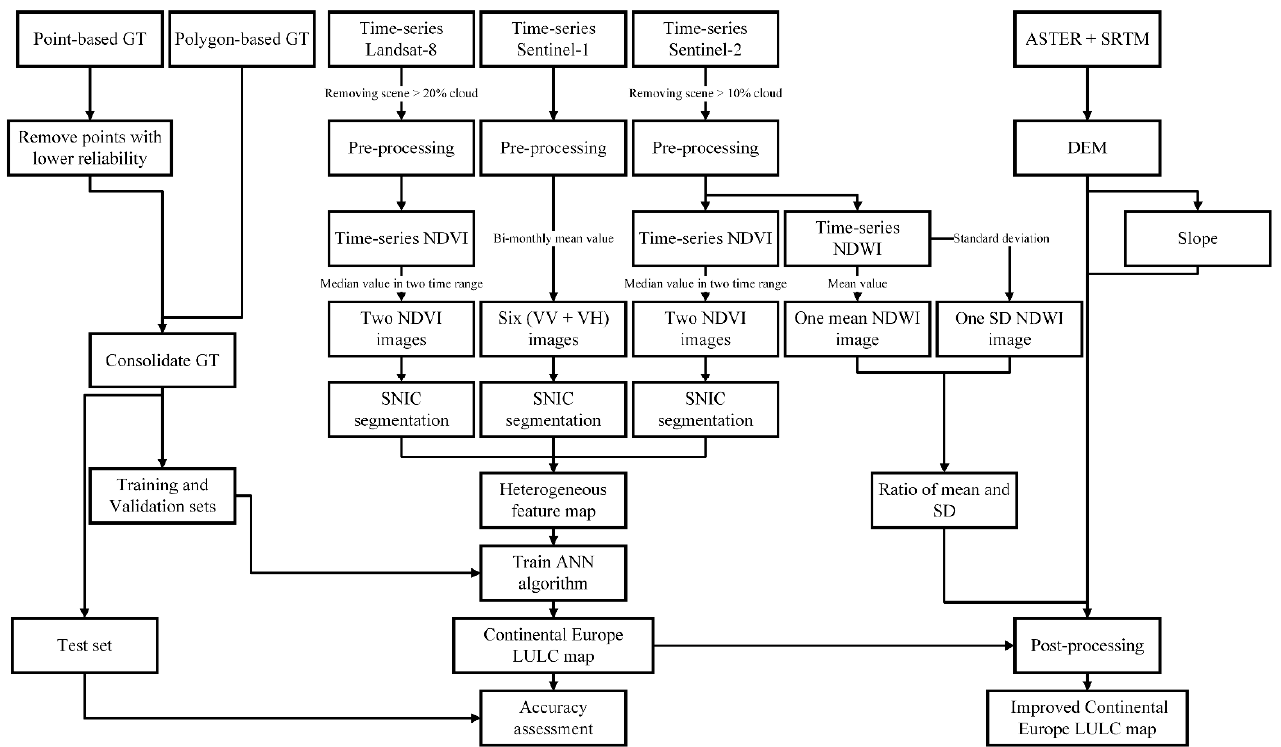
Figure 3. The flowchart used for generating the ELULC-10 map (GT: Ground Truth as LUCAS reference samples, ASTER: Advanced Spaceborne Thermal Emission and Reflection Radiometer, SRTM: Shuttle Radar Topography Mission, DEM: Digital Elevation Model, NDVI: Normalized Difference Vegetation Index, NDWI: Normalized Difference Water Index, SNIC: Simple Non-iterative Clustering, SD: Standard Deviation, ANN: Artificial Neural Network, and LULC: Land Use Land Cover). Table 3. The number of satellite images from 2016 to 2021 (e.g., Sentinel-1, -2, and Landsat-8) utilized for providing features after the preprocessing